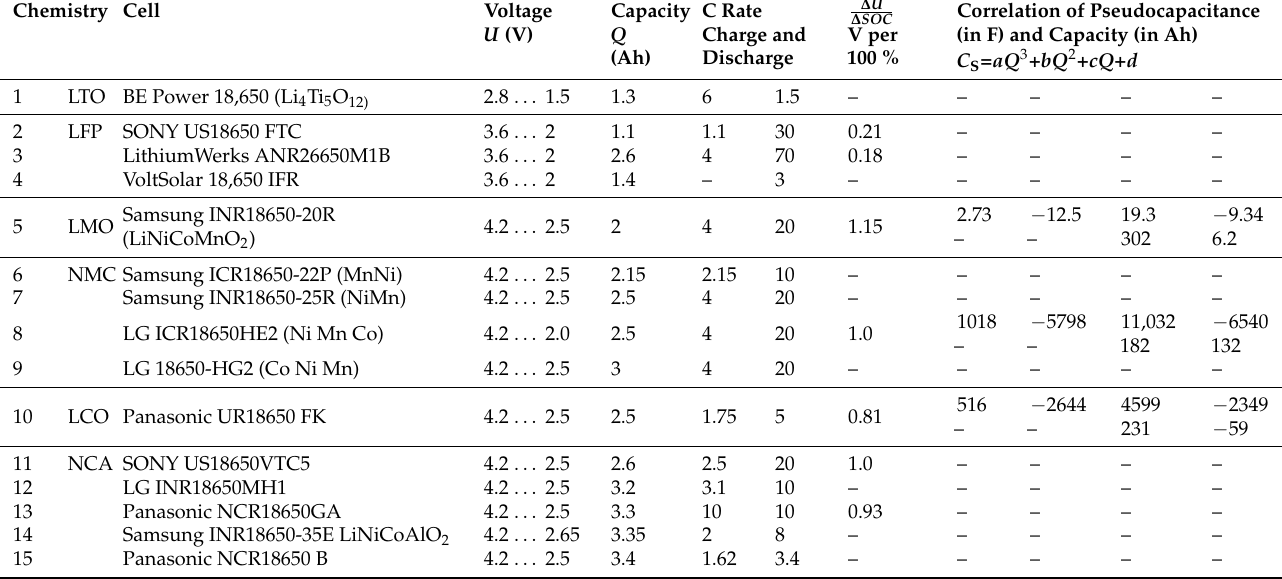
Table 1. Lithium-ion batteries in this study. Nominal data according to manufacturers’ data sheets. Approximate slope of the voltage-SOC curve (see Section 3.6). Cubic and linear approximation of the capacitance-capacity curve (see Section 3.2). Chemistry Cell Voltage U